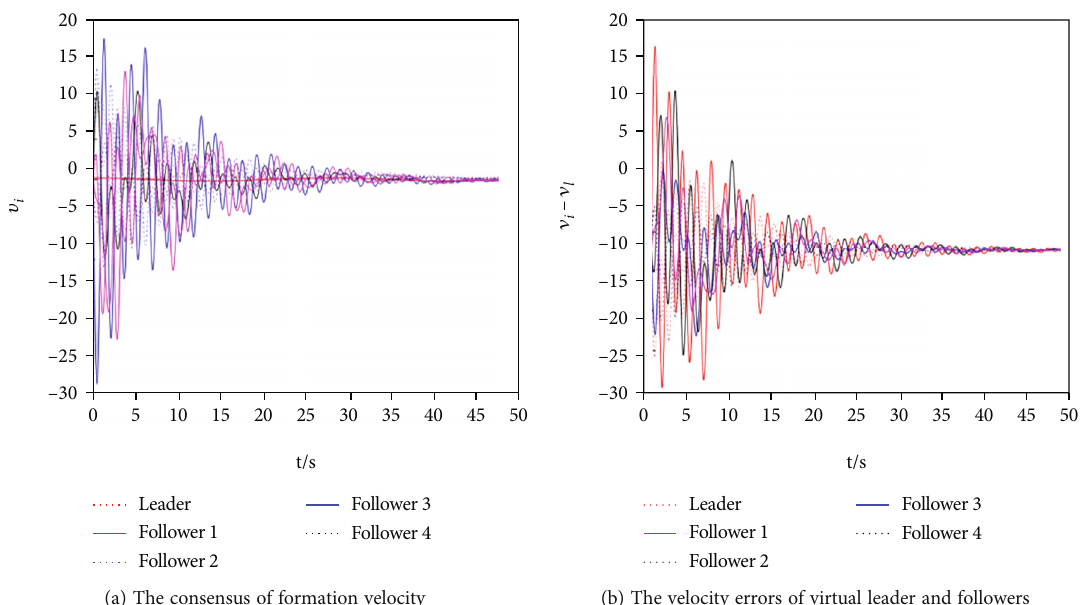
Figure 6: The consensus of formation velocity and velocity errors.